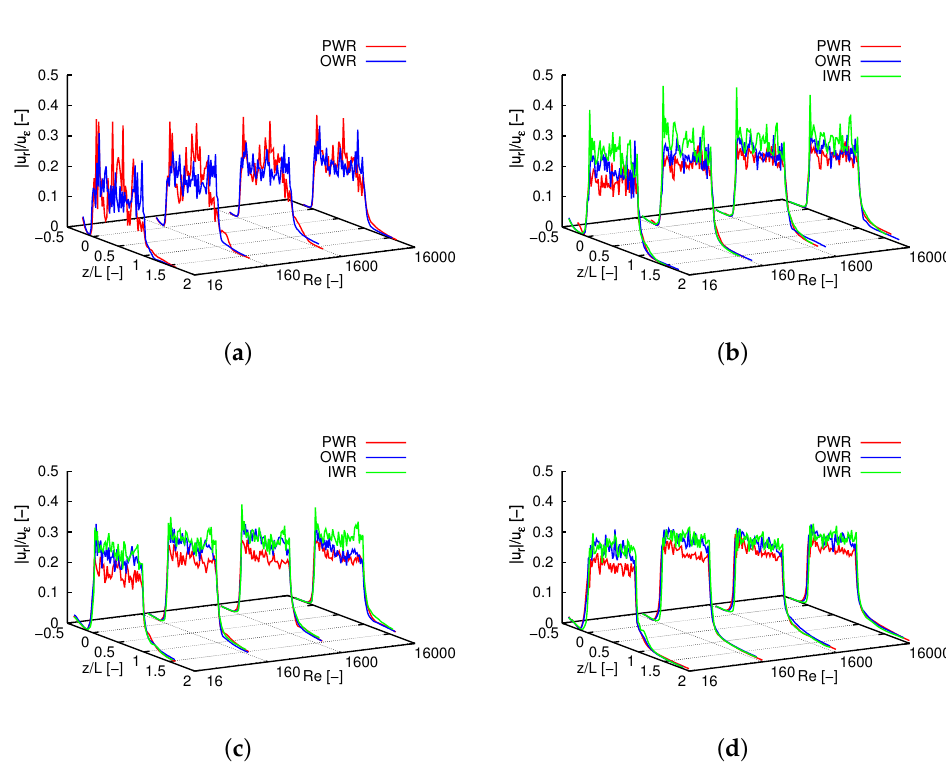
Figure 13. Axial progression of the area averaged magnitude of the radial velocity normalized with the interstitial velocity. ( a ) D / d P = 2.8, ( b ) D / d P = 4.8, ( c ) D / d P = 6.8, ( d ) D / d P = 8.8.